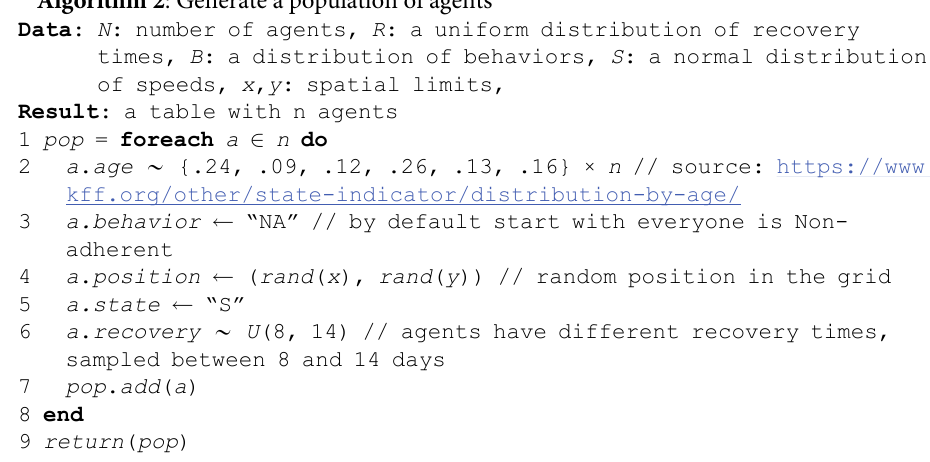
Algorithm 2 : Generate a population of agents